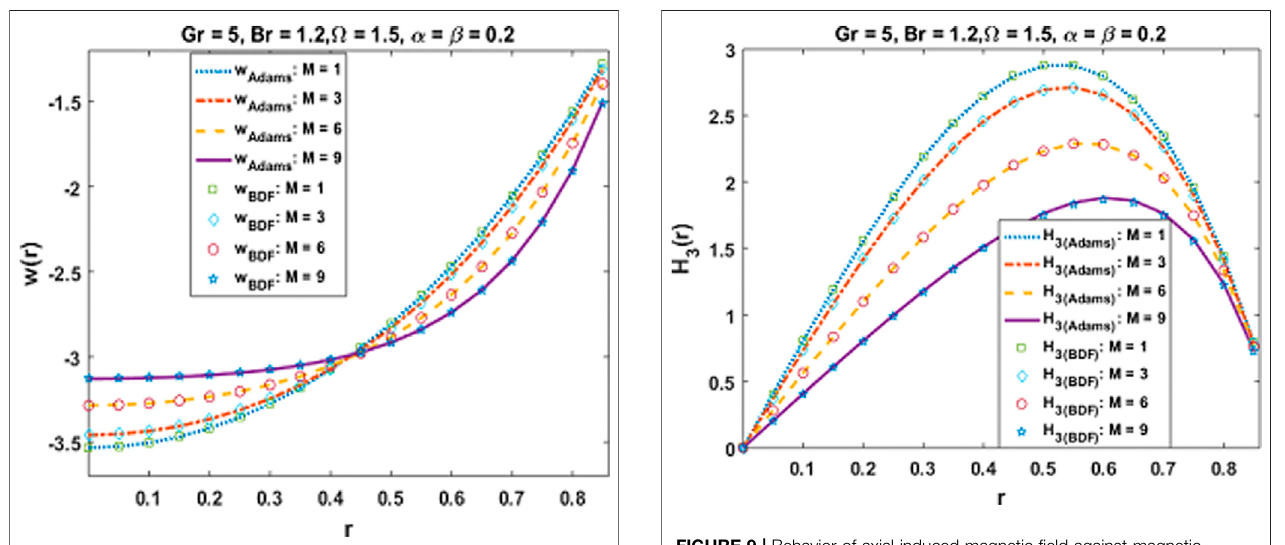
FIGURE 9 | Behavior of axial induced magnetic fi eld against magnetic parameter.